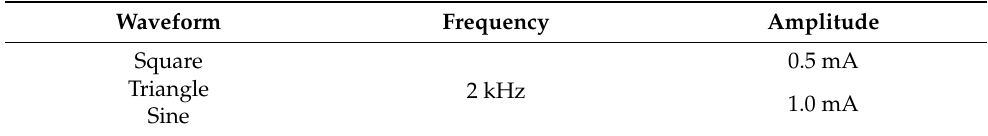
Table 1. Parameters of the drive current.